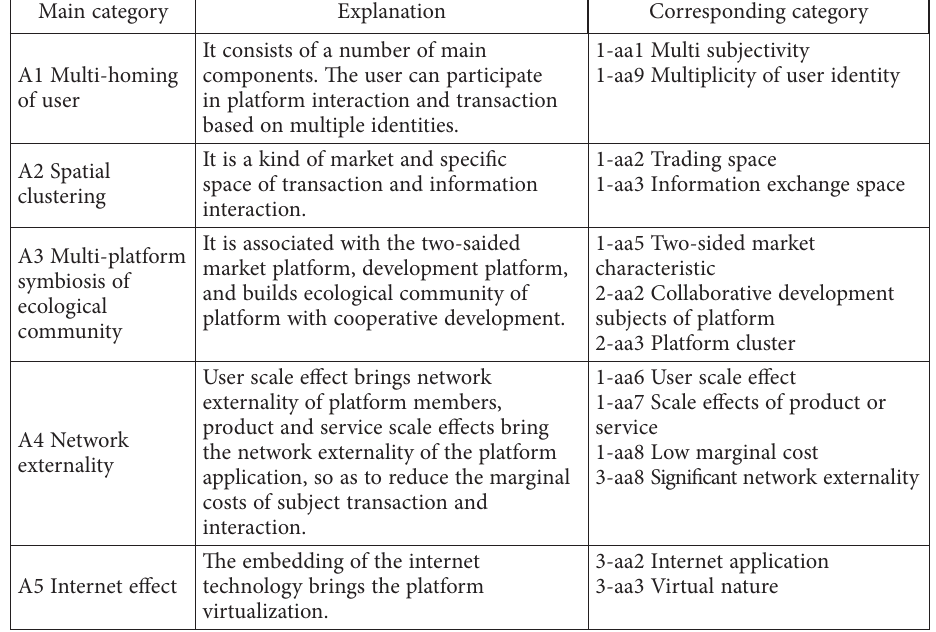
Table 3. Main categories and corresponding categories which are formed by axial coding Main category Explanation A1 Multi-homing of